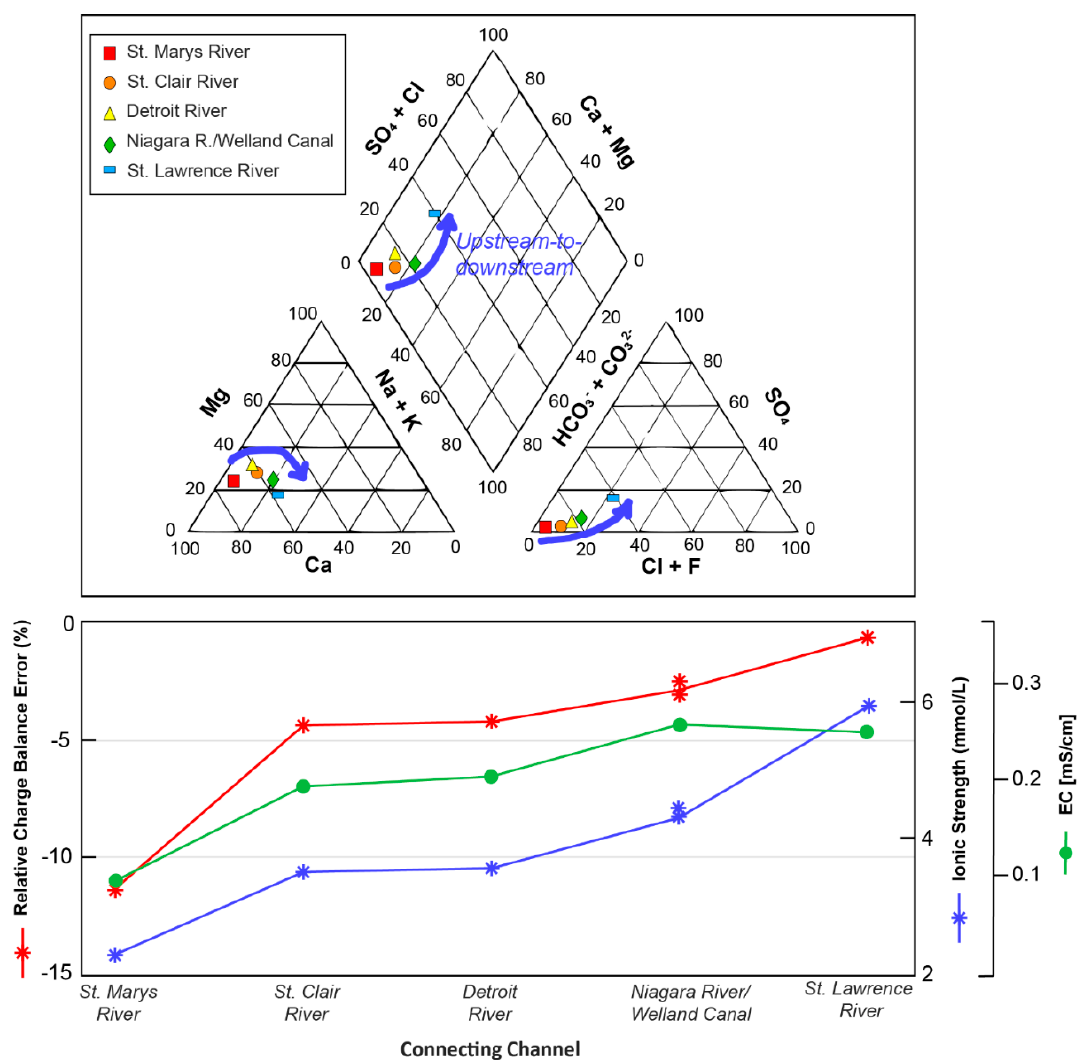
Figure 1. Top frame: major ion geochemistry of the connecting channel surface waters in a Piper Ternary diagram (%-meq L − 1 for all axes), and, bottom frame: comparison of simulated charge balance (% error; left y-axis) to ionic strength and electric conductivity (right y-axes) across the simulated connecting channel surface waters.